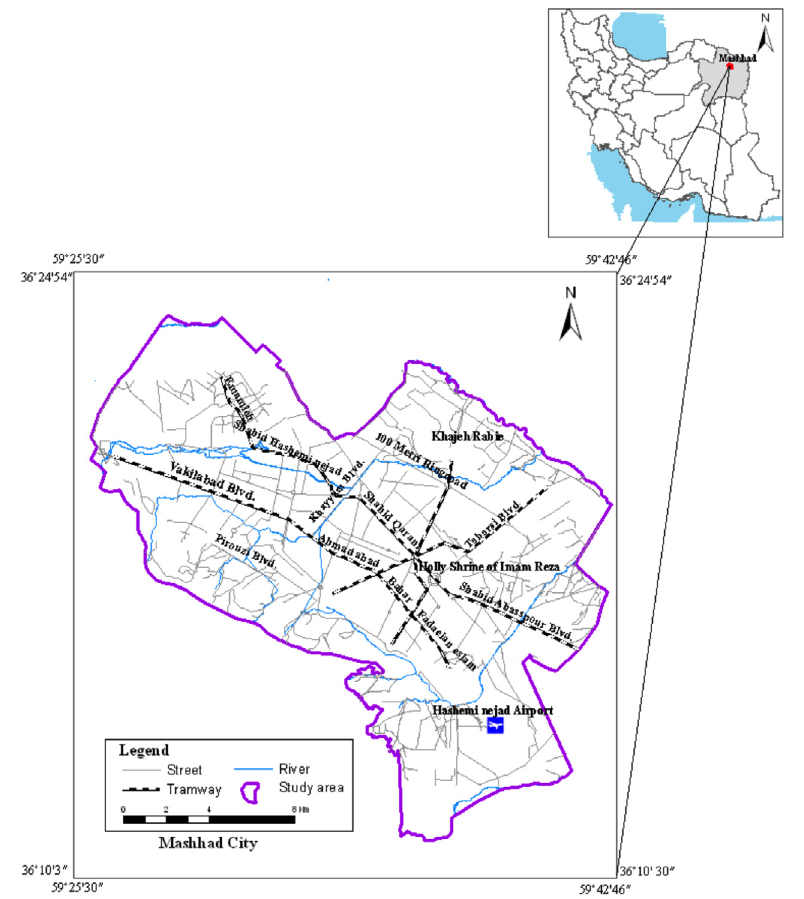
Figure 1. The location map of the study